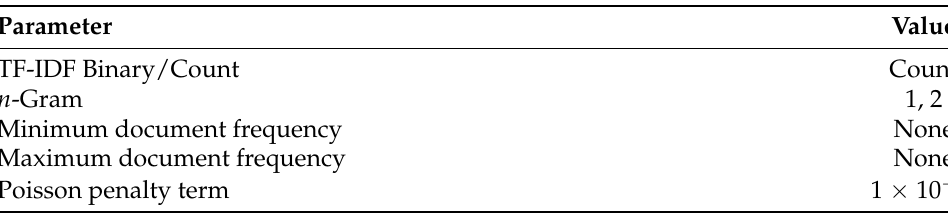
Table 2. Generalized Linear Model (GLM) pipeline